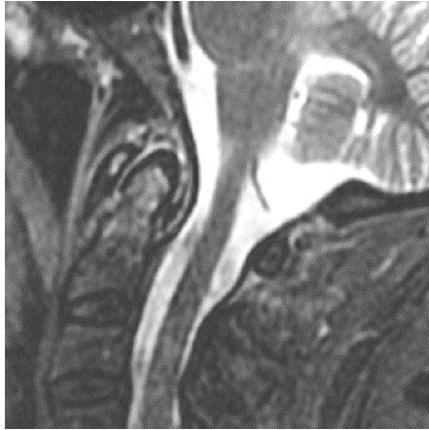
Figure 1: Sagittal STIR sequence demonstrating bone marrow edema within the C2 odontoid process. There are also high signal changes in the surrounding soft tissues reflecting related inflamma- tion.